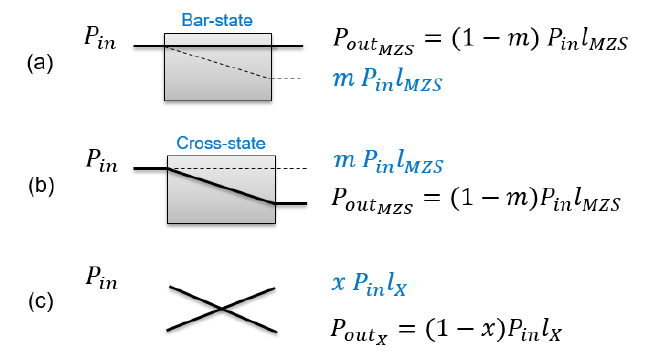
Figure 1. Unwanted powers are denoted in blue, m and x represent, respectively, the factors of the leaked power portions in the MZI ( a ) and ( b ), and waveguide crossing ( c ).